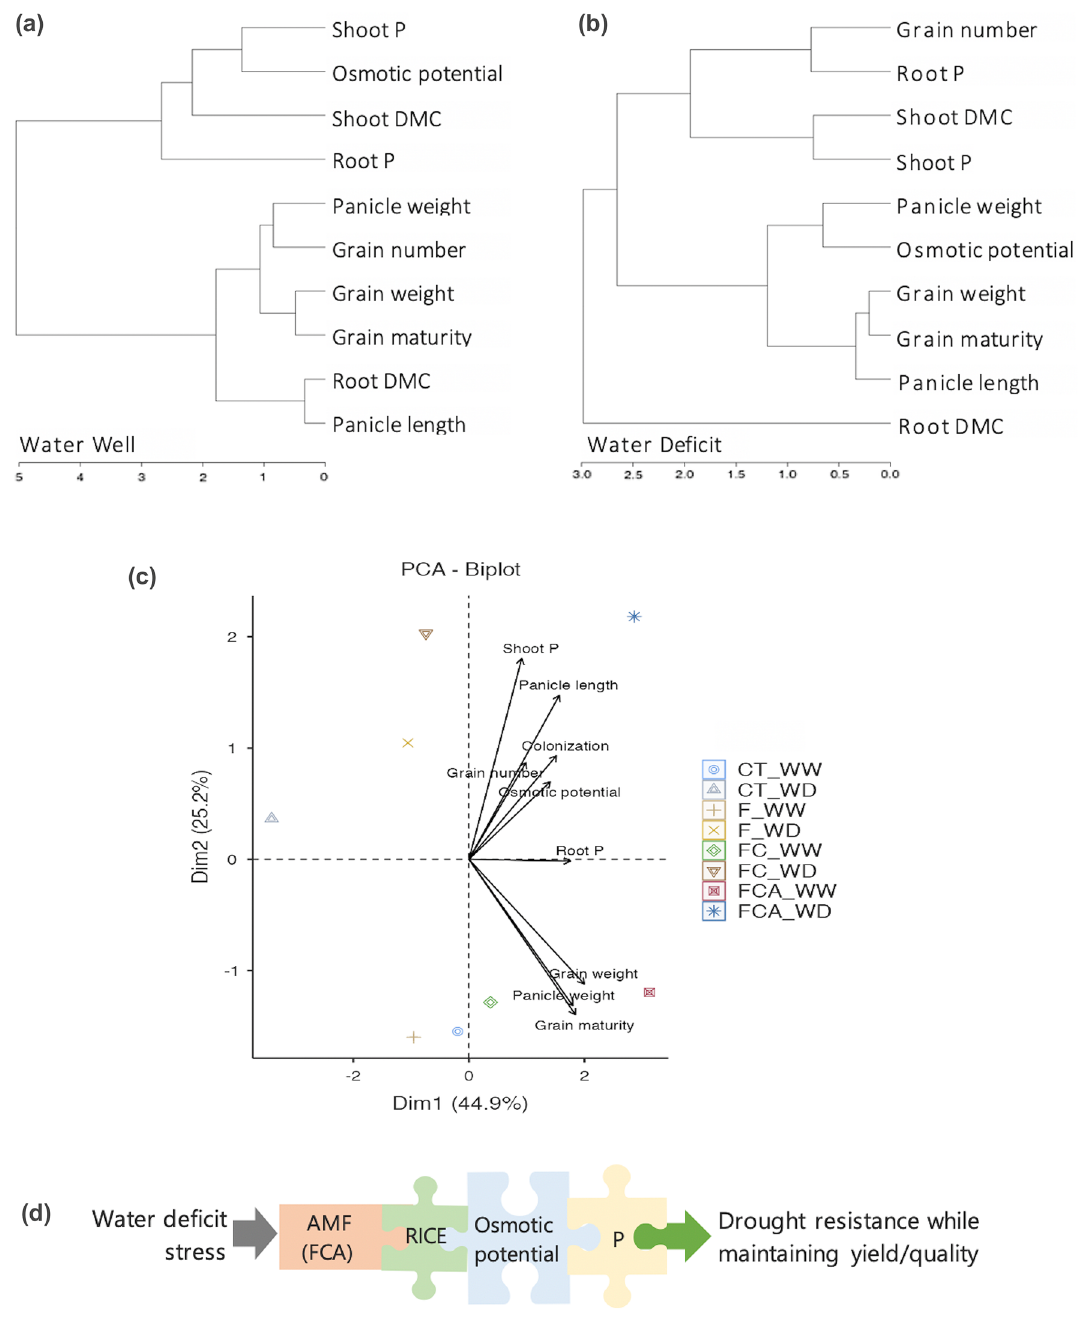
Figure 7. Clustering of separated well-watered ( a ) and water deficit ( b ) conditions in relationship of osmotic potential and phosphorus content into the reproductive parts (panicle – grain production, quality) and vegetative (dry matter content, DMC, of shoot and root) parts in rice cv. Leum Pua inoculated with or without AMFs (F, FC, FCA, and CT). PCA summary ( c ) in effect of the AMF colonization on osmotic potential, phosphorus (P) and reproductive yields. Systematic diagram jigsaws ( d ) depicting the effect of osmotic potential and phosphorus regulation by the AMF (FCA type) on rice yield maintenance under water deficit to the reproductive yields under the WW. At the site of the WD, the osmotic potential and phosphorus content, especially in root, were closely related to panicle weight and grain number, respectively (Fig. 7a,b). While emphasizing the influence of the AMF colonization on the osmotic potential, phosphorus content, and reproductive yields. The findings revealed a high relationship between the root phosphorus content and the colonization in the WW and WD conditions (Pearson coefficient; R > 0.8, Supplementary Table S2). Furthermore, when compared to the three inoculations in the WW and WD, the FCA inoculation showed a trend to towards the colonization influence rather than the others (Fig. 7c). It may involve a slightly high level in the percentage